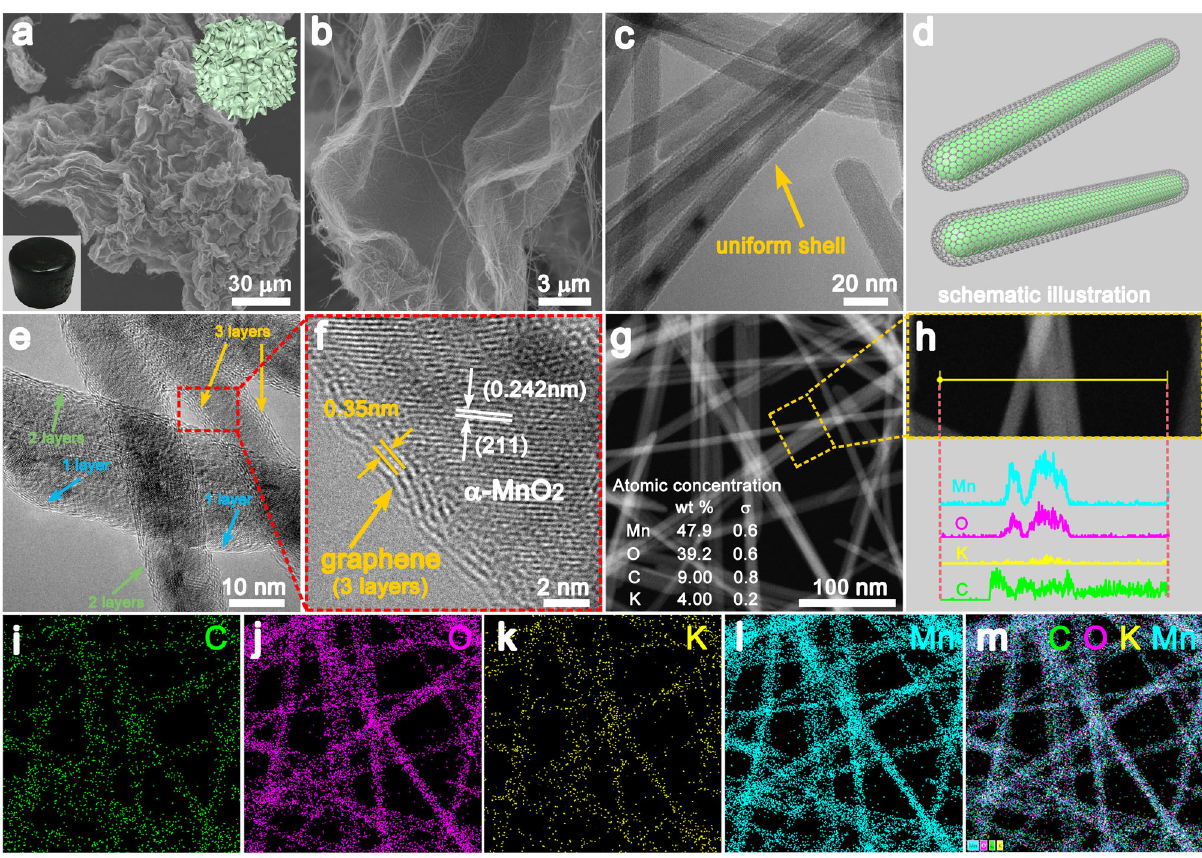
Fig. 2 The morphology of the 3D hierarchical MnO 2 @GR. a , b SEM images of 7.50% MnO 2 @GR. Inset: the optical images of 3D MnO 2 @GR. The magni fi ed images in ( b ) clearly reveal the 3D structure is woven from the uniform nano fi ber. c TEM images of 7.50% MnO 2 @GR, reveal the uniform core – shell structure of the nano fi ber. d Schematic illustration of MnO 2 @GR nano fi ber. e , f HRTEM images of 7.50% MnO 2 @GR, showing the graphene shells are about three layers (less than 2 nm). g – m HAADF-STEM image ( g ) and corresponding EDX linear scanning ( h ) and maps scanning of 7.50% MnO 2 @GR for C ( i ), O ( j ), K ( k ), Mn ( l ) and combined image ( m